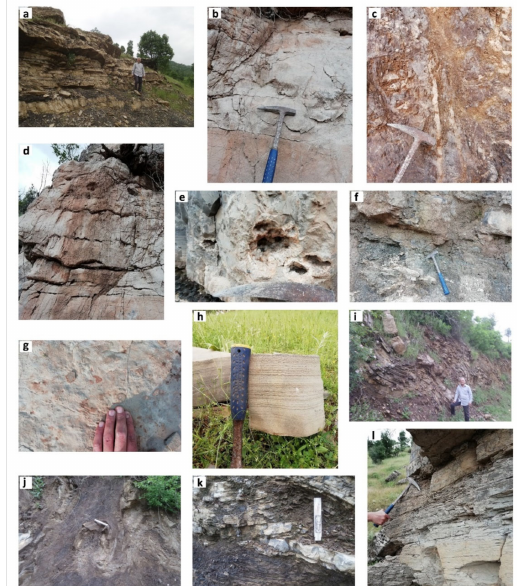
Figure 3. ( a ) Dolomite beds interbedded with dark grey-black shales in the lower part of the Sarki Formation. ( b ) Evidence of tectonic deformation in the form of fractures and joints within the Sarki Formation. ( c ) Veins filled with white calcite within the dolomite beds of the Sarki Formation. ( d ) Highly fractured dolomite beds of the Sehkaniyan Formation. ( e ) Quartz geodes within the upper part of the Sehkaniyan Formation. ( f ) Dolomite beds alternate with limestones and shales in the lower part of the Sargelu Formation. ( g ) A few ammonites within the Naokelekan Formation. ( h ) Common stromatolitic structure including stylolite (pressure solution) within the limestone of the contact area between the Naokelekan Formation and the overlying Barsarin Formation. ( i ) Minor folds in the contact area between the Naokelekan Formation and the overlying Barsarin Formation. ( j ) Tectonic deformation in the form of box folding within the Barsarin Formation. ( k ) The contact area between the Barsarin Formation and the overlying Chia Gara Formation. ( l ) Fissile shales interbedded with dolomitic limestones in the lower part of the Chia Gara Formation. Scales